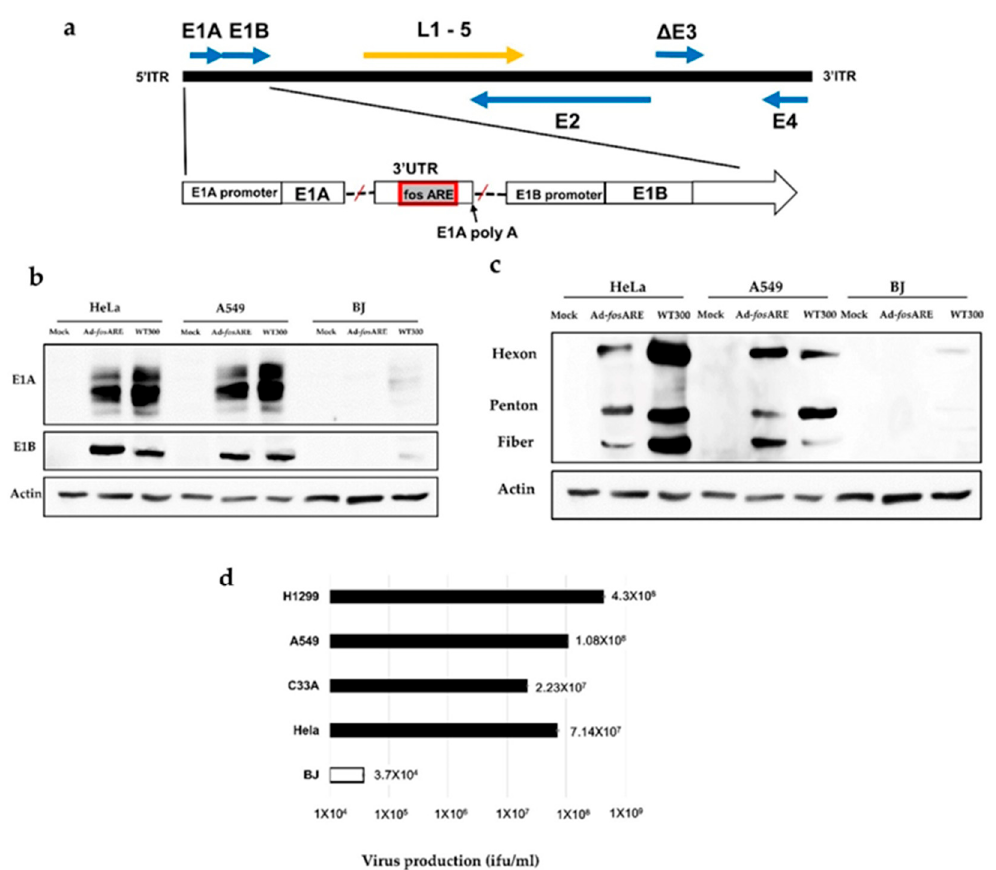
Figure 1. The structure of Ad- fos ARE and its production efficiency. ( a ) Schematic representation of Ad- fos ARE with c-fos ARE in the 3’-UTR of the E1A gene. Arrows indicate the location of early (E1, 2, and 4) and late (L1–5) genes. ( b ) Expression of viral proteins in Ad- fos ARE and WT300-infected cells. A549, HeLa, and BJ cells were infected by both viruses and the expression of early proteins E1A, E1B and ( c ) late proteins hexon, penton, and fiber (right) were estimated by western blot analysis. Actin expressions were also assessed as the internal control. ( d ) Cancer (HeLa, C33A, A549, and H1299) cells and normal (BJ) cells were infected with Ad- fos ARE at an MOI of 10 ifu/cell and virus production was determined 48 h after infection. Each titer (ifu/ml) is shown on the graph. Data presented here are mean ± standard deviation of three independent experiments.